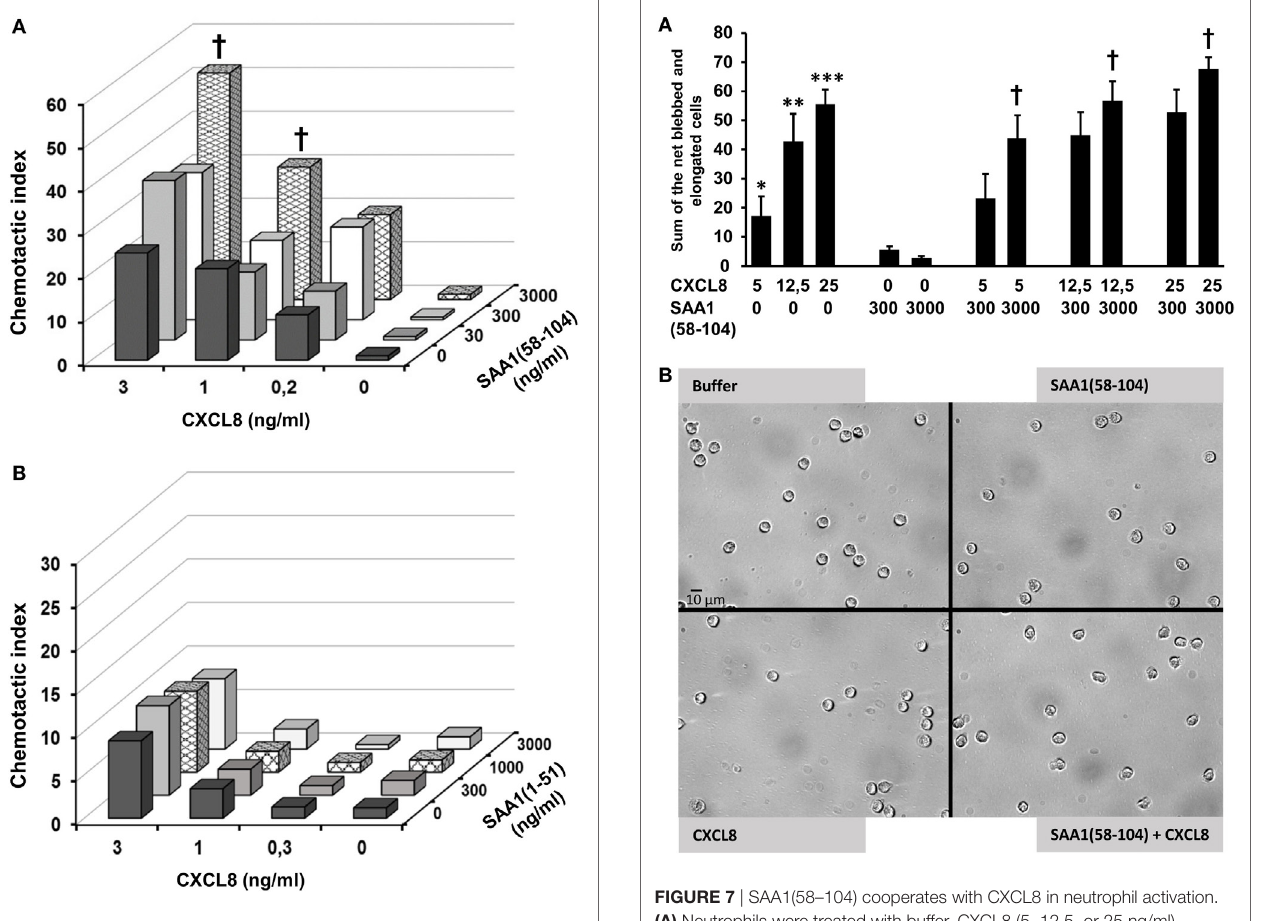
FigUre 6 | SAA1(58–104), but not SAA1(1–51), cooperates with CXCL8 in neutrophil chemotaxis. The COOH-terminal peptide SAA1(58–104) (30–3,000 ng/ml) (a) and the NH 2 -terminal peptide SAA1(1–51) (300–3,000 ng/ml) (B) were added in the presence or absence of CXCL8 (0.2–3 ng/ml) to the lower compartment of the Boyden microchamber to measure human neutrophil chemotaxis. The chemotactic response is expressed as the mean chemotactic index ± SEM derived from three to five independent experiments. Statistically significant cooperation, determined by the Mann–Whitney U test, is indicated by daggers ( † p <